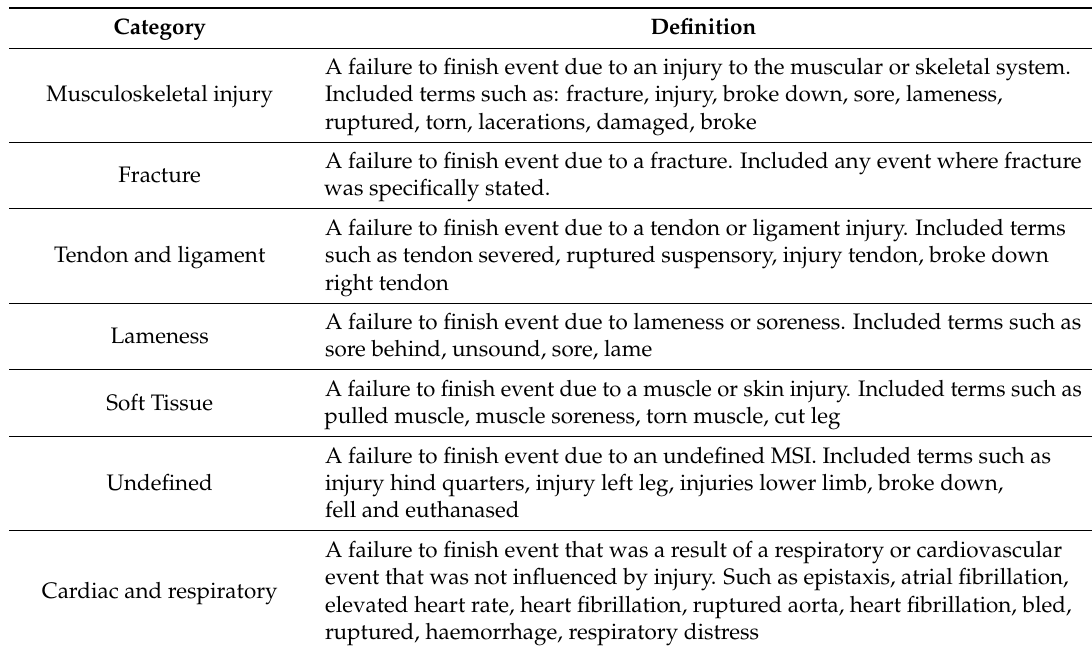
Table 1. Categories and definitions used to describe failure to finish veterinary events reported by Stipendiary Stewards occurring during Thoroughbred flat races in New Zealand